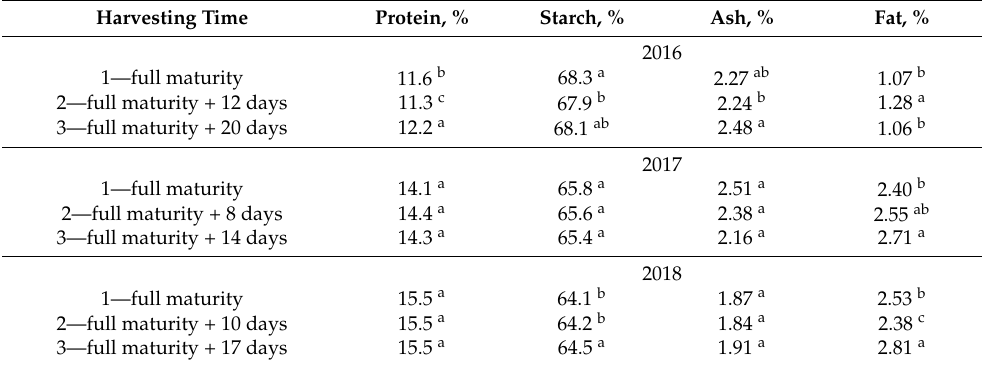
Table 5. Protein, starch, ash, and fat contents in spring wheat